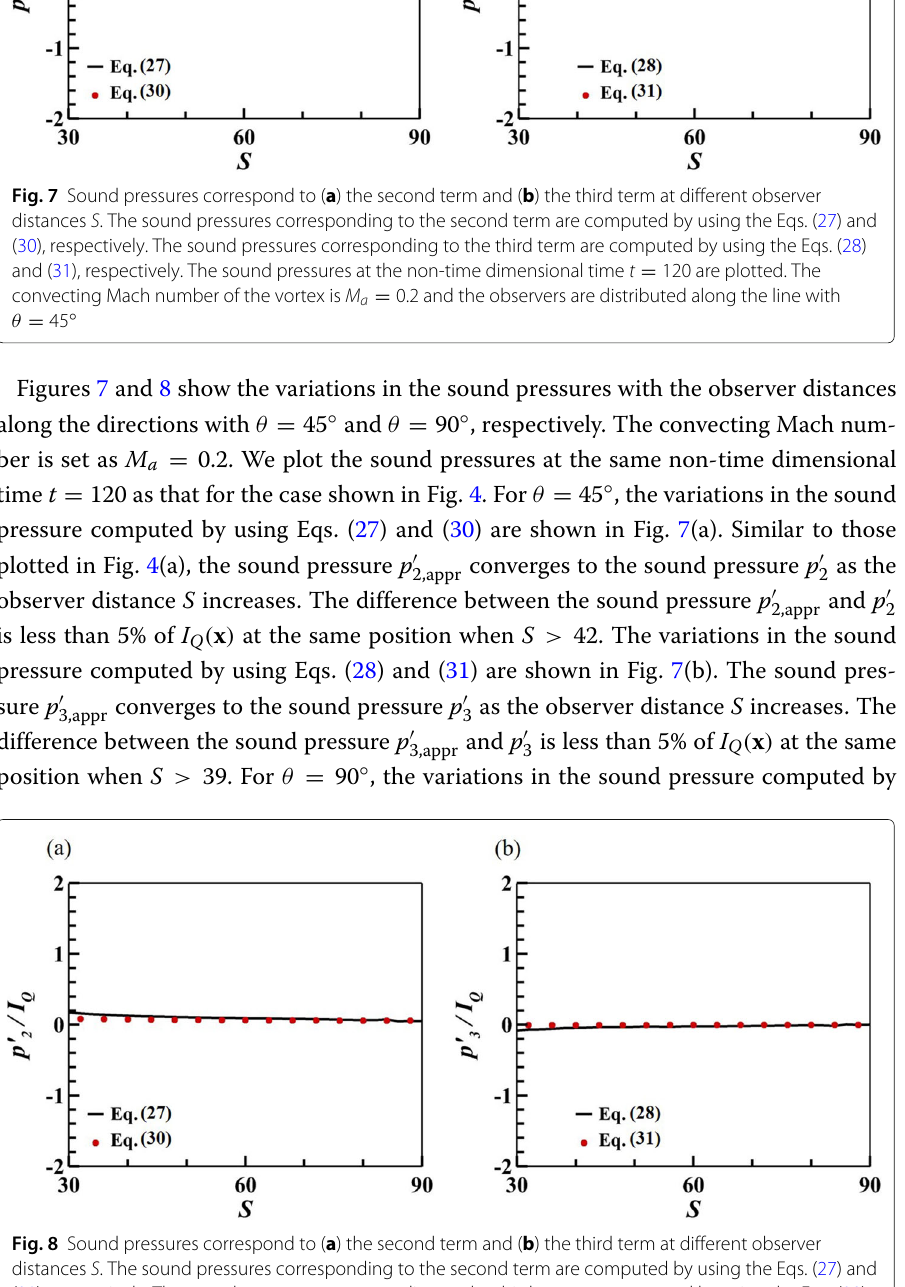
Fig. 8 Sound pressures correspond to ( a ) the second term and ( b ) the third term at different observer distances S . The sound pressures corresponding to the second term are computed by using the Eqs. (27) and (30), respectively. The sound pressures corresponding to the third term are computed by using the Eqs. (28) and (31), respectively. The sound pressures at the non-time dimensional time t = 120 are plotted. The convecting Mach number of the vortex is M a = 0.2 and the observers are distributed along the line with θ = 90